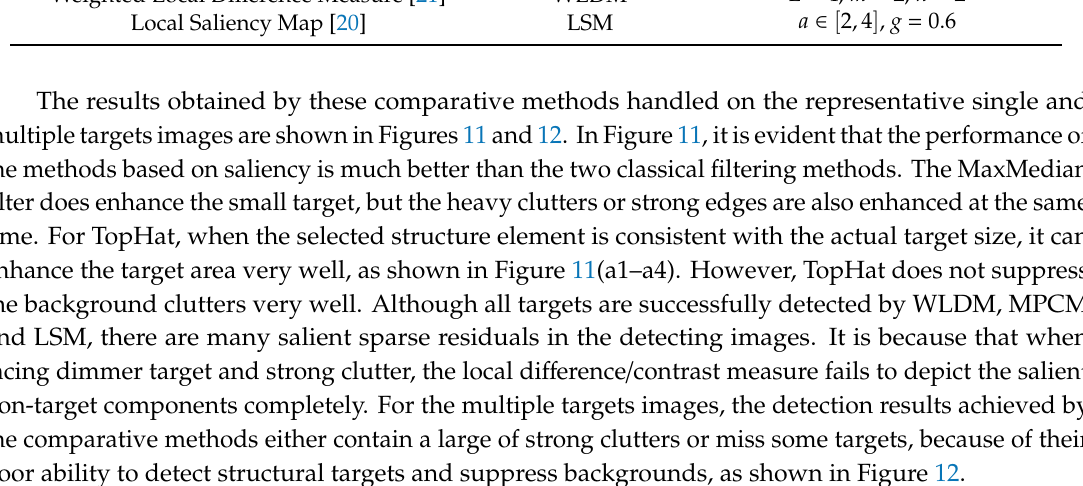
Figure 12. Representative multiple targets images from the datasets and the target images obtained by saliency-based methods and the proposed one. ( 5 )–( 8 ) are four representative multiple targets images from the tested datasets. In Figure 13, the ROC curves of Sequences 1–6 implemented by TopHat, MaxMedian, WLDM, MPCM, LSM are provided. The curves indicate that our proposed method work better than other competitive methods. However, it is interesting to note that the TopHat achieves an impressive detection performance in tested sequences. The main reason is that the selected structure element matches the tested sequences with slowly varying background very well, which is suited to filtering-based methods. Moreover, the detection performance of saliency-based methods changes greatly. The major reason lies in that for different sequences, there are various strong disturbances that have higher contrast than targets in local background, causing high false alarm. The G SCR , BSF and G LSNR of the filtering and saliency-based methods are summarized in Table 5. It shows that the